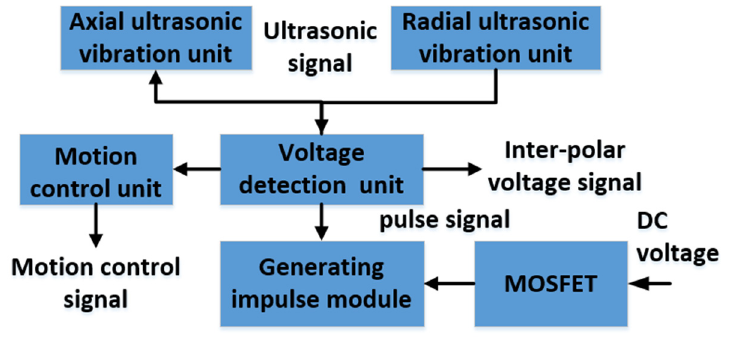
Figure 5. Detection system components.